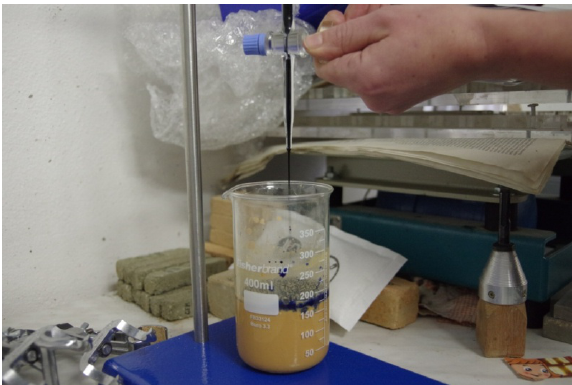
Figure 1. An earth sample with methylene blue so- lution. Earth sample with the solution is stirred on a mag- netic stirrer 1 minute for each 1 millilitre of solution. After that a drop of the mixture is placed on a fil- ter paper. This process is repeated and each sample drop with increasing amount of methylene blue solu- tion is marked (Fig. 2). Methylene blue test is fin- ished when a blue ring spreads around a drop sample (Fig. 3) because clay has already adsorbed the max- imum amount of methylene blue dye. Amount of dye adsorbed depends on a kind and amount of clay. Amount of dye adsorbed is deter- mined by the Eq. 1. Amount of dye adsorbed is defined as the weight amount of dye in grams that is adsorbed by 1 kilogram of test